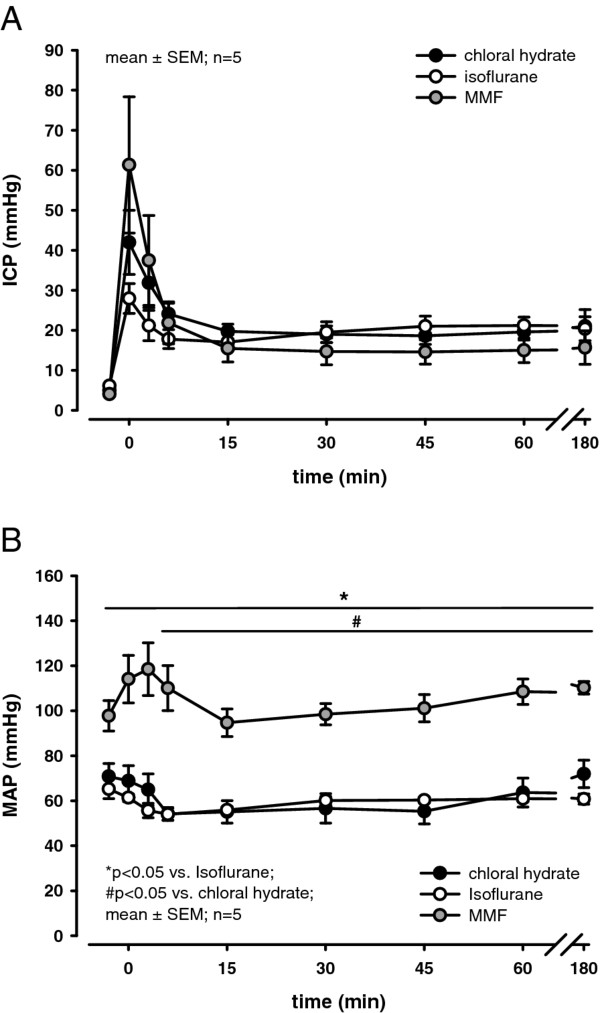
(A) Time course of ICP until 180 minutes after SAH. No significant differences were observed between groups. (B) Time course of dynamic MAP changes until 180 minutes after SAH. MAP was significantly higher before and after SAH when animals were anesthetized with MMF as compared to chloral hydrate or isoflurane. SAH induced a Cushing response (transient increase of MAP due to increased ICP) in animals anesthetized with MMF while no such response was observed in the isoflurane or chloral hydrate groups. ICP and MAP were recorded continuously, averaged over 3 minutes, and displayed as means ± SEM (n = 5 in each group; *p < 0.05 vs. isoflurane, #p < 0.05 vs. chloral hydrate; Kruskal-Wallis ANOVA on ranks followed by Dunn's post-hoc test).